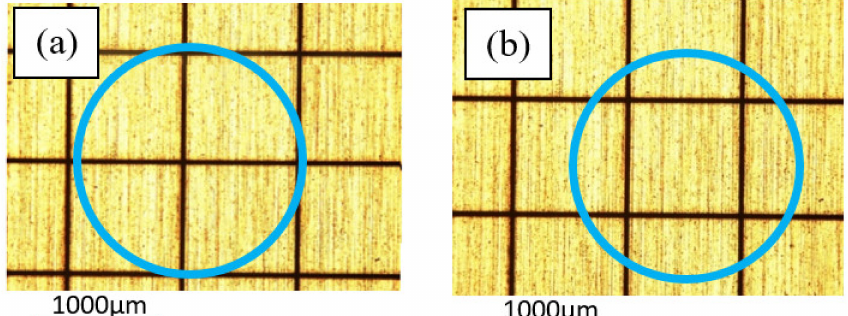
Figure 7. Sketch of two possible positions of a 2 µ L droplet deposited on the square lattice having a pitch of 910 µ m. The blue circle represents the droplet ( a ) enclosed by the crossed scan lines and ( b ) enclosing a machined square. The circle dimension was calculated for a droplet of 2 µ L and a CA of 116 ◦ and resulted in being equal to 1.4 mm.